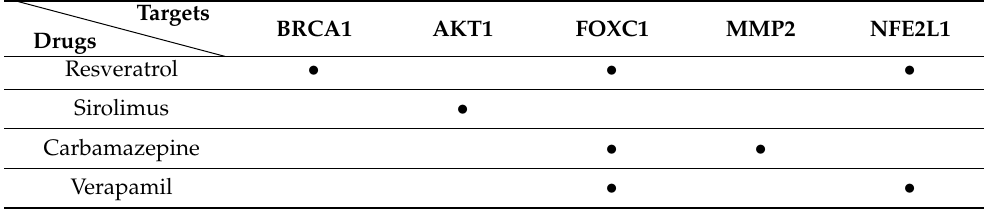
Table 5. Potential multiple-molecular drugs and their corresponding target genes for non-TNBC. • : The targets of the potential multi-molecule